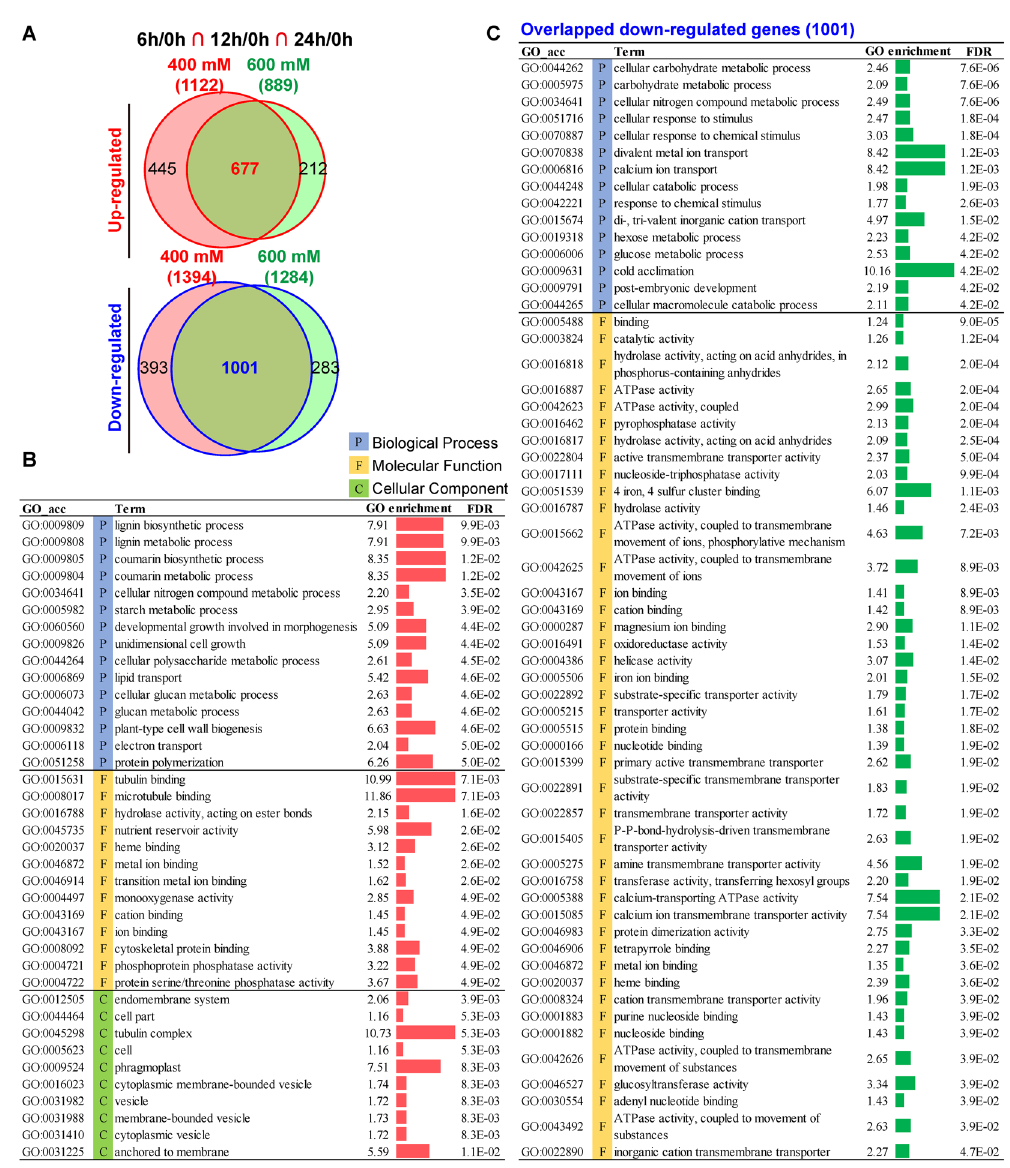
with few genes involved. Among the above nine functional categories, the most well-represented one is the plant hormone signal transduction. Based on the GO enrichment analysis in Fig. 3, the biological process (BP) related with calcium ion (Ca 2 + ) transport were significantly enriched in down-regulated genes (8.42-fold). As an important secondary mes- senger, Ca 2 + plays crucial role in plant response to various stresses. We then constructed an integrate signal transduction-transcriptional regulatory network based on the known Ca 2 + signal transduction and the regulatory network from Fig. 5. As shown in Fig. 6, the dark blue arrows (active or repress) connected the known Ca 2 + signal transduction in response to salt stress and the other edges connected our study identified up-regulated genes (red nodes), down-regulated genes (green nodes), or the TFs (cyan nodes) with the known Ca 2 + signal transduction network. According to previous study 30 , when plants percept the elevated Na + under salt stress, Ca 2 + and ABA signal cooperated to regulate a series molecular and physiological responses through SOS pathway. Based on the relationships between TFs and up-/down-regulated genes connected with Ca 2 + or ABA, the TFs were classified into three main clusters: TFs in cluster 1 have strong correlation with the DEGs connected with both Ca 2 + and